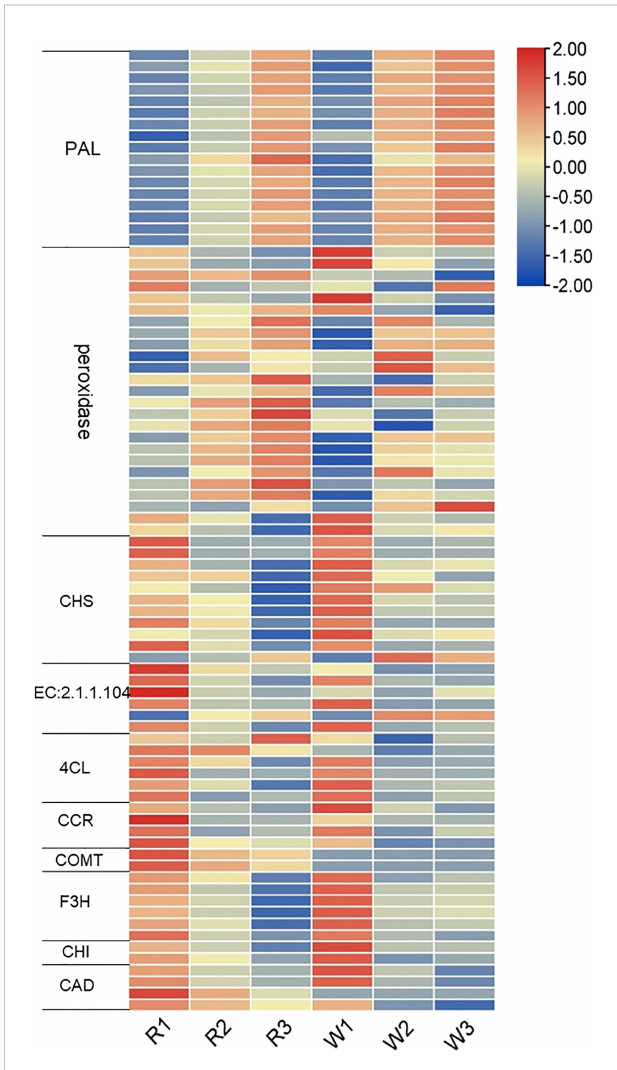
FIGURE 5 Expression analysis of the differentially expressed genes (DEGs) in the phenylpropane biosynthesis pathway at different nut fl ower development stages. The red and blue colors represent upregulated and downregulated gene expression, respectively. On the left are the names and classi fi cations of the genes in the phenylpropane biosynthesis pathway. PAL , phenylalanine ammonia-lyase; CHS , chalcone synthase; 4CL , 4-coumarate:CoA ligase; CCR ,